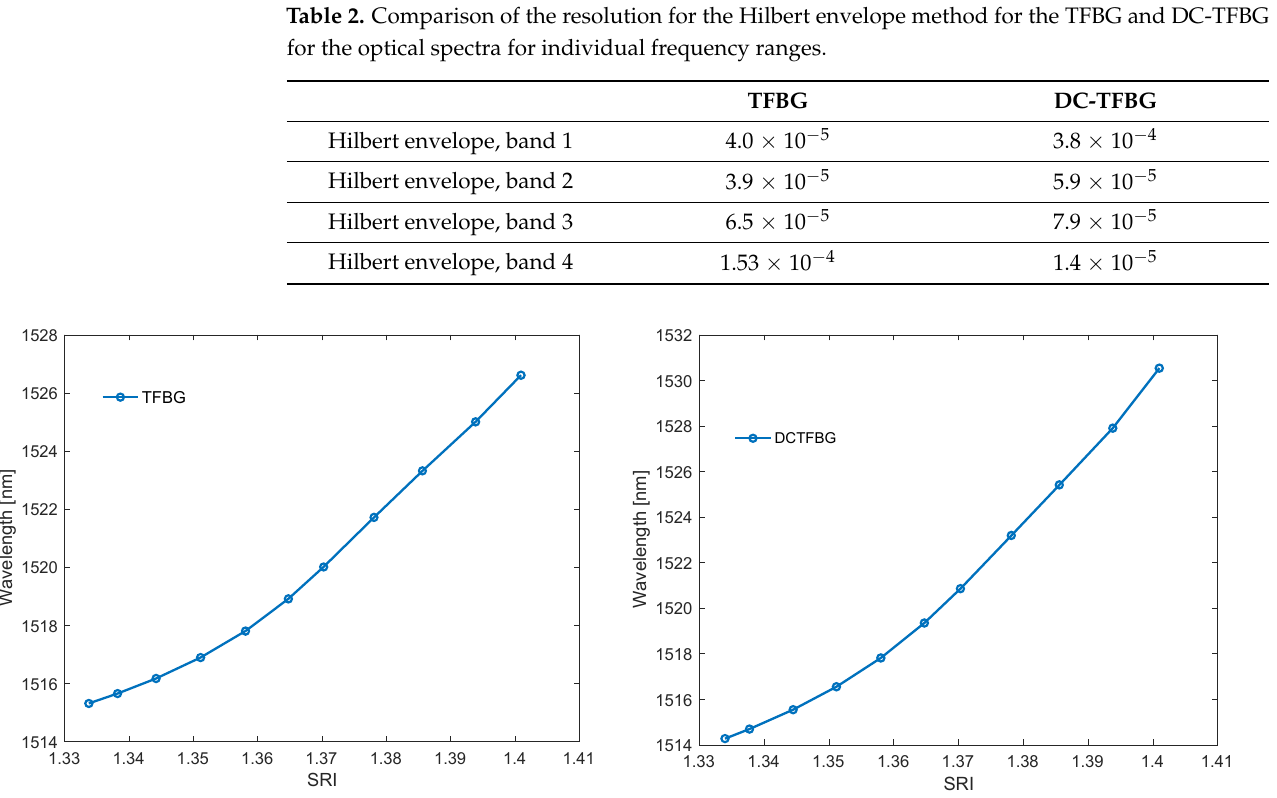
Figure 14. Change of normalised Hilbert envelope from SRI for TFBG (band 1) and DCTFBG (band 2). Table 2. Comparison of the resolution for the Hilbert envelope method for the TFBG and DC-TFBG for the optical spectra for individual frequency ranges.